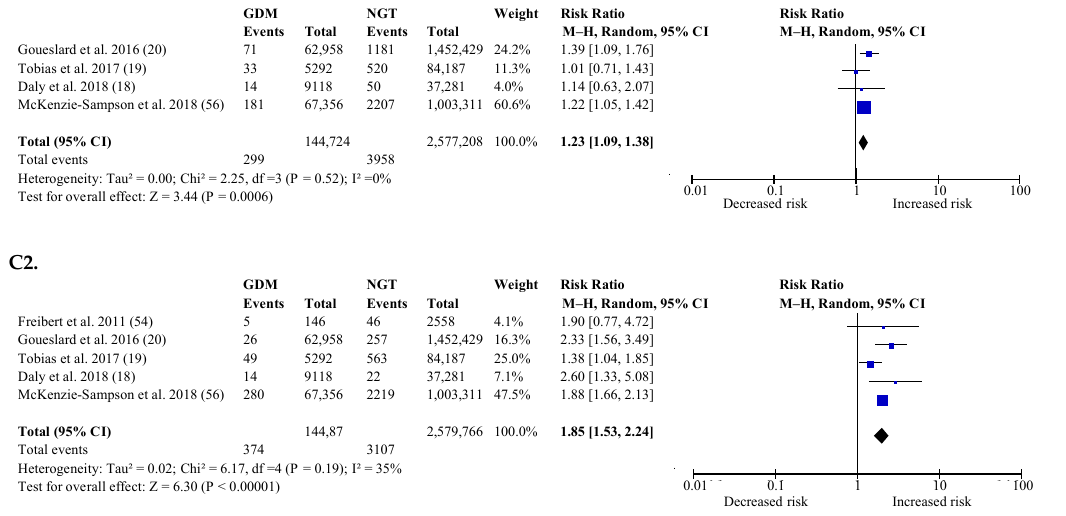
Figure 2. The overall postpartum risk for glucose intolerance and cardiovascular events in women with a history of GDM compared to NGT women: ( A ) Type 2 diabetes mellitus (T2DM), ( B ) prediabetes, ( C1 ) stroke, and ( C2 ) myocardial infarction. T2DM: Type 2 diabetes mellitus; GDM, gestational diabetes mellitus; 95% CI: confidence interval; M–H: Mantel–Haenszel method; df: degrees of freedom; RR: relative risk or risk ratio. X-axis is log scale of RR. Squares represent the RR of an individual study. The size of the square is proportional to the weight of the study, which was calculated using a random-effects model. The horizontal lines indicate 95% CI. The diamond represents the pooled RR with its 95% CI.